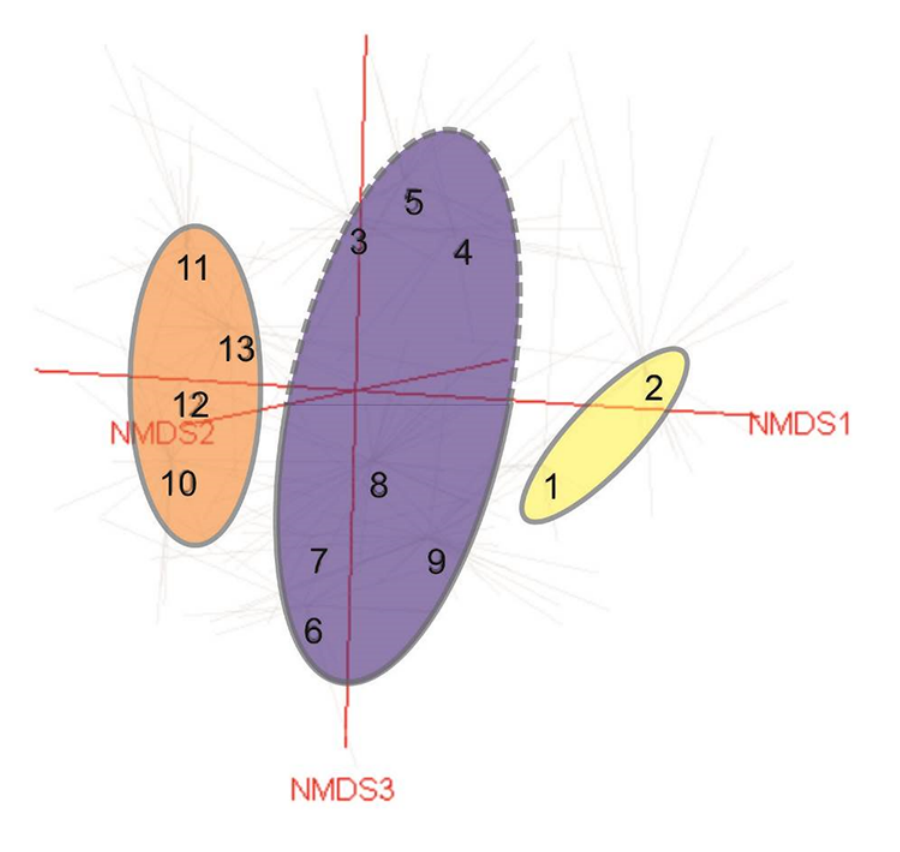
Figure 3 NMDS ordination of chasmophytic vegetation in the study area. Note that in this analysis groups with small number of relevés classified as communities were